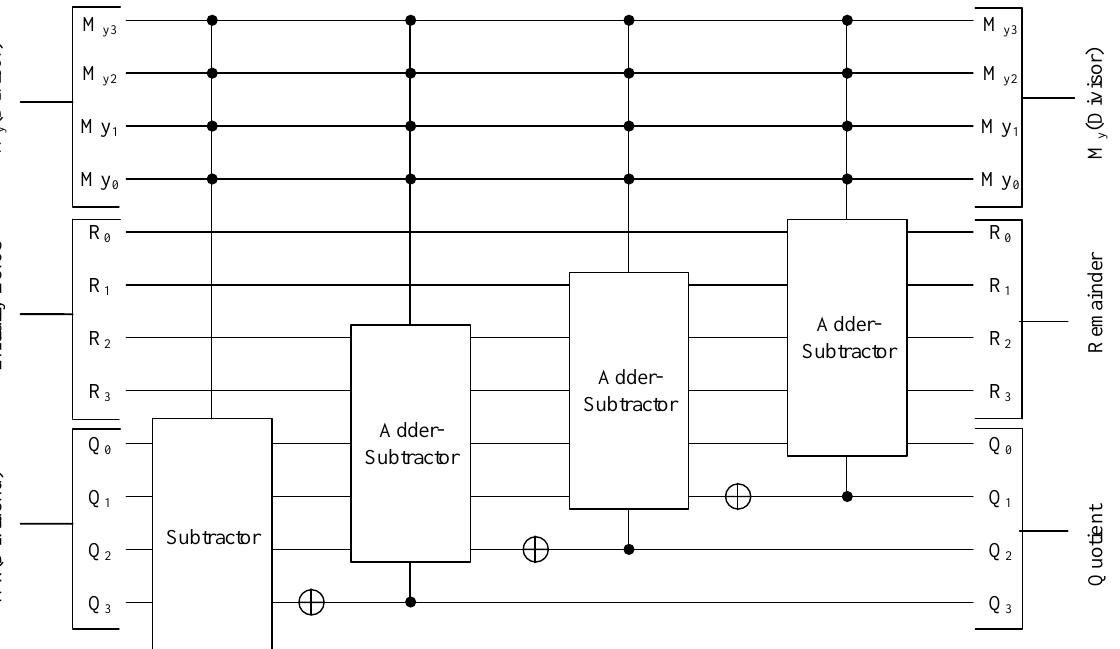
Figure 11. Quantum non-restoring division circuit for four qubit